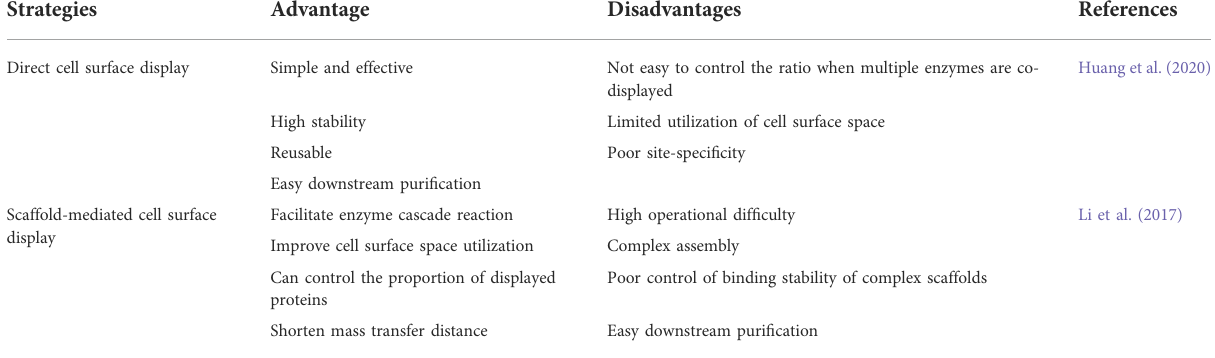
TABLE 1 Advantages and disadvantages of each